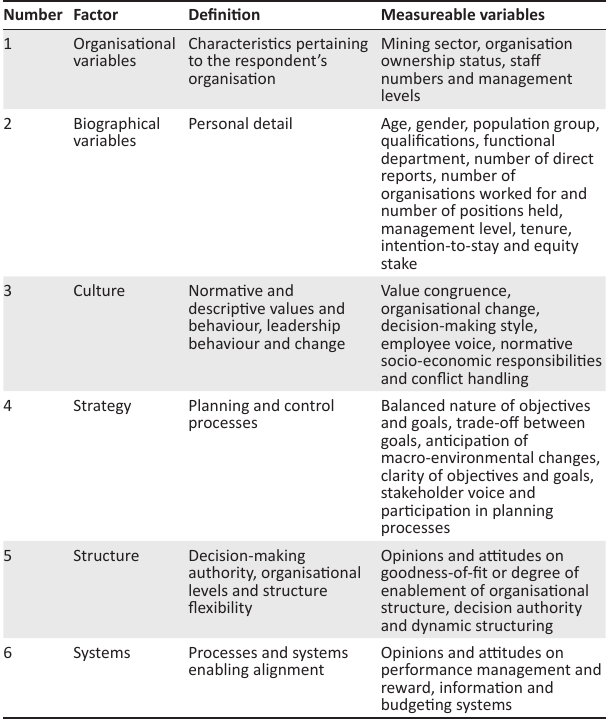
TABLE 2: Potential factors influencing organisational